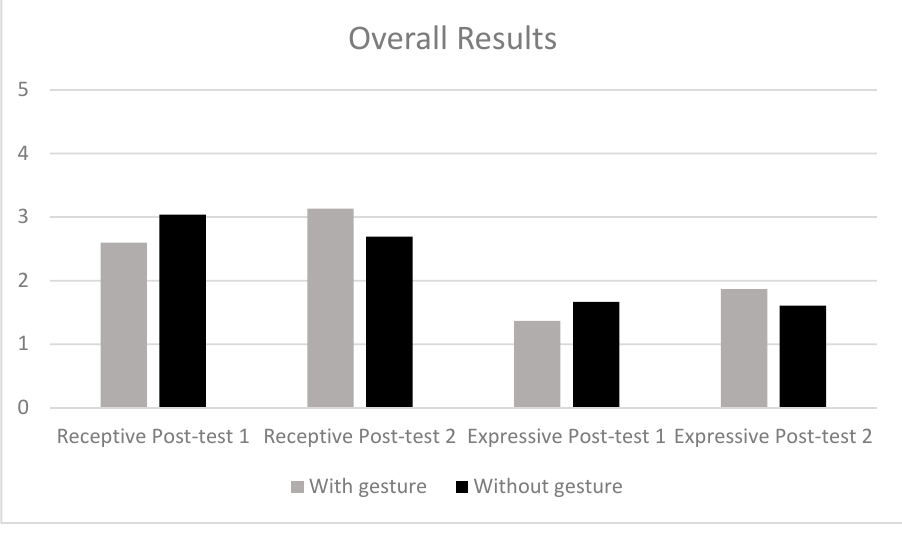
Figure 2. Mean accuracy scores by timepoint x mode conditions, with and without gesture.